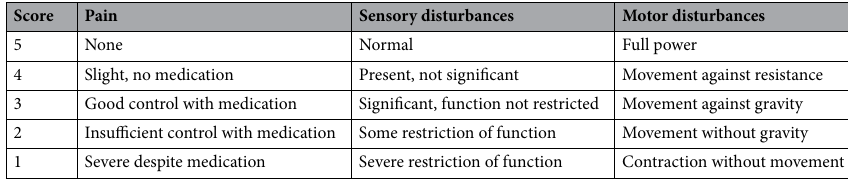
Table 1. Neurological scores. Symptoms were grouped into three clinical categories: pain, sensory disturbance, and motor